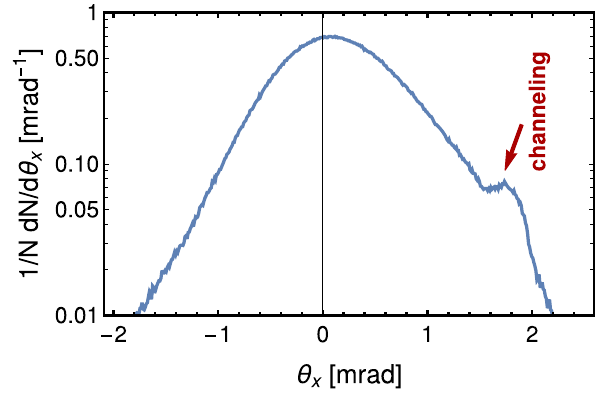
Fig. 18 Angular distribution of a deflected electron beam with an energy of 855 MeV, representing the beam conditions of the Mainz Mikrotron MAMI (University of Mainz, Germany), and a 175 µ m thick Si crystal which is bent along the (111) planes with a deflection angle of 1.75 mrad Table 3 Optimized crystal parameters for the planned experimental setup Parameter Value Bent crystal thickness 175 µ m Bent crystal bending angle Bent crystal transverse position Bent crystal angular alignment